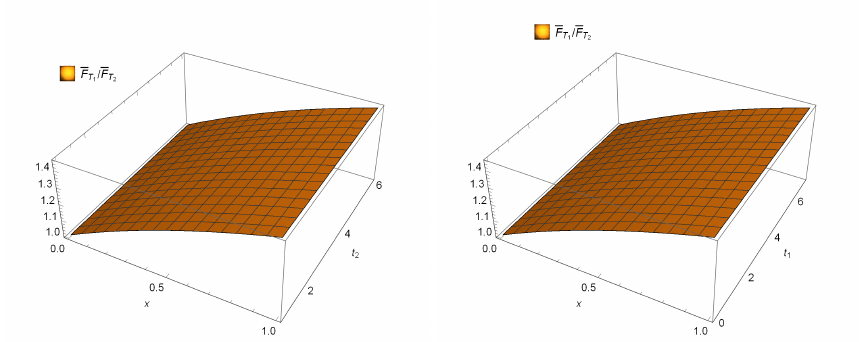
Figure 6. The graphs of the ( ¯ F ( RX T 1